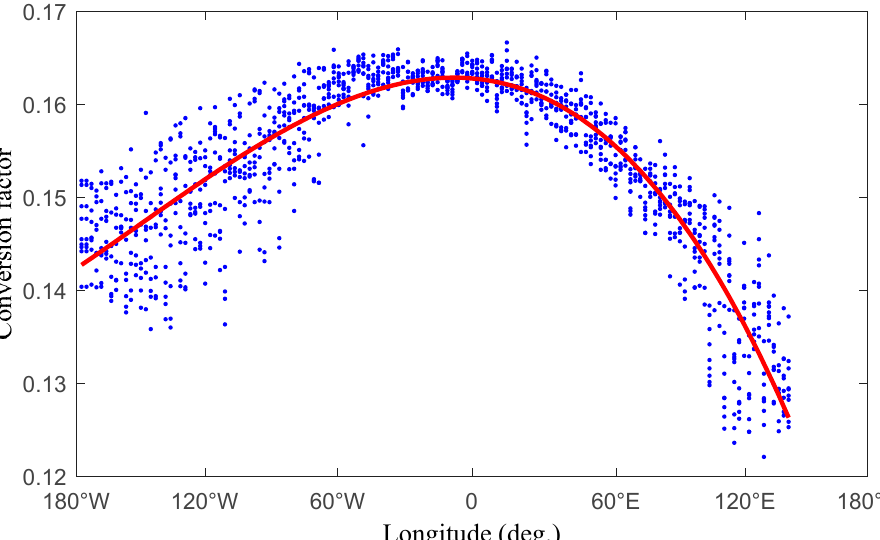
Figure 4. Relationship between the conversion factor and the longitude using the data of grid points globally from the year 2013.